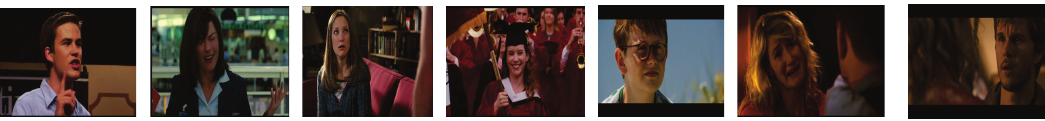
Figure 13. Examples of images in the SFEW database. The emotions from left to right are: anger, disgust, fear, happy, normal, sadness and surprise.